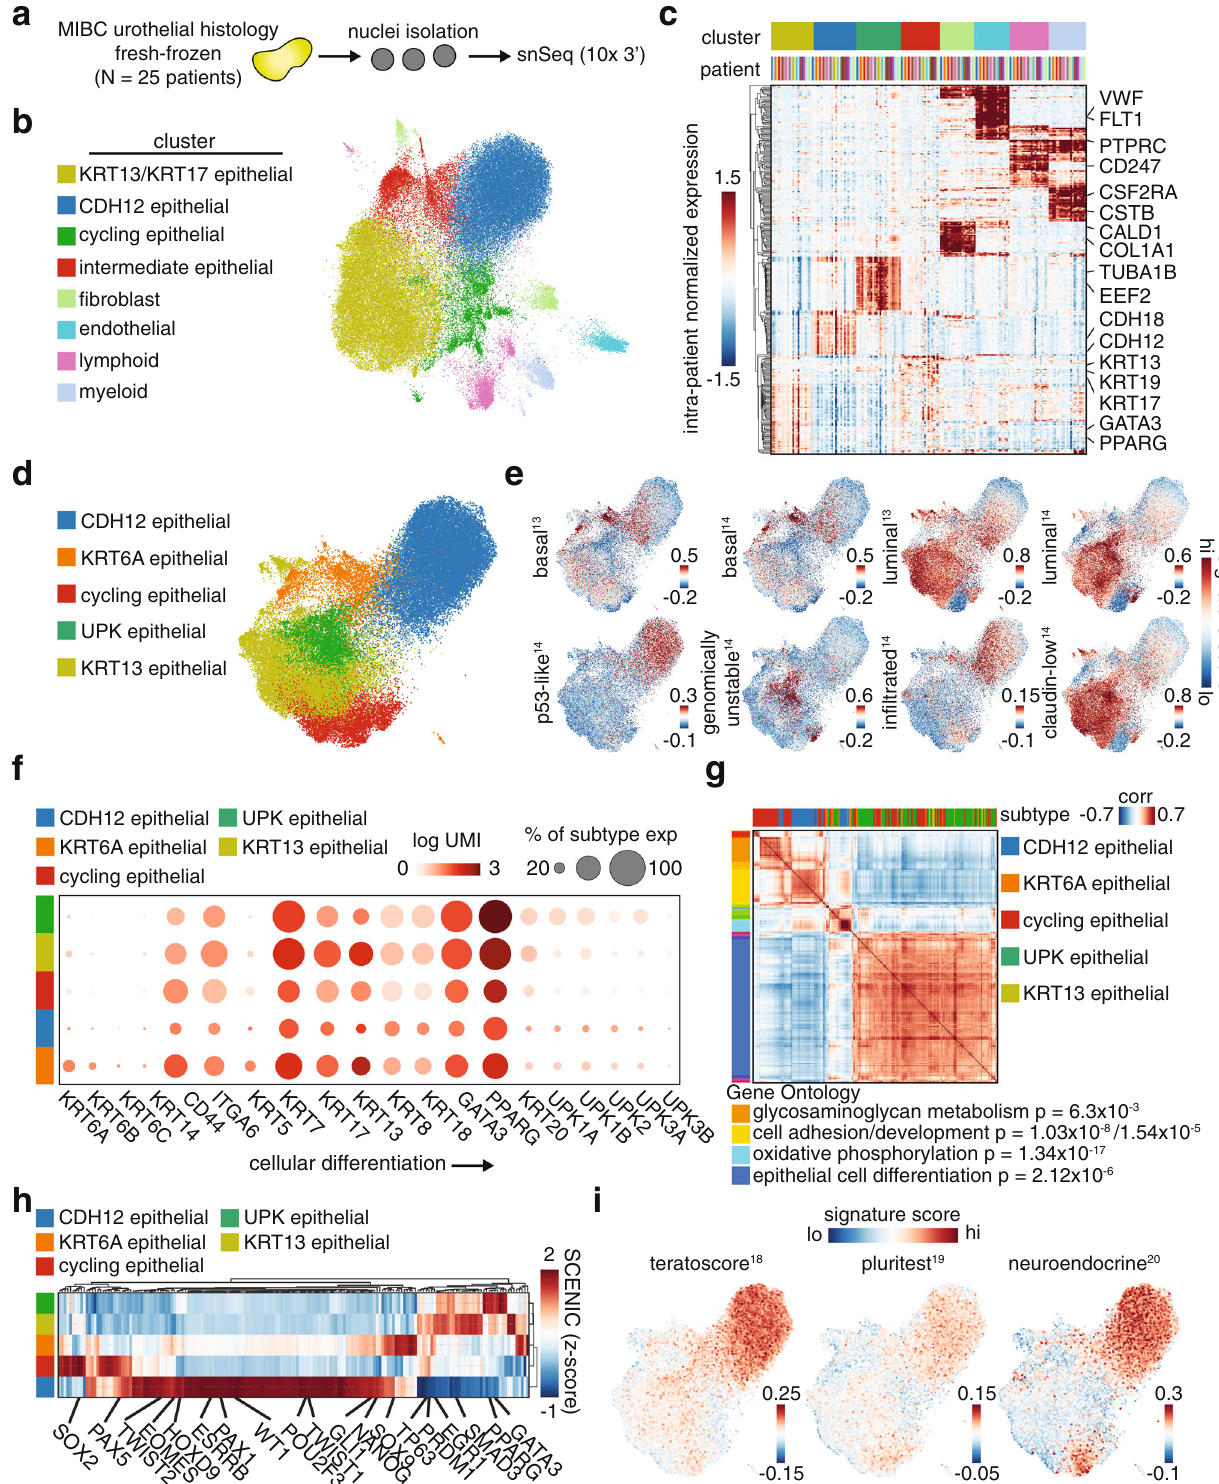
Fig. 1 Discovery of a CDH12 + tumor cell population by single-nucleus sequencing. a Work fl ow for single nucleus sequencing; MIBC — muscle invasive bladder cancer. b UMAP of all nuclei (71,832) in MIBC dataset colored by unsupervised clustering. c Average gene expression per patient of marker genes for each cell type in b . d UMAP of all epithelial nuclei (52,983) in MIBC dataset colored by epithelial population. e Gene signature scores for published MIBC subtype gene sets. f Uroepithelial differentiation-related marker gene expression in each epithelial population, where the dot size indicates the percent of cells within the subtype with non-zero expression of the respective gene. g Gene-gene correlations partitioned into co-expression modules annotated for epithelial population enrichment. Gene ontology (GO) annotations are included with g:SCS multiple testing corrected p-values for hypergeometric testing. h Activity scores for SCENIC transcription factor regulons in each epithelial population. i Gene signature scores for stem-cell and neuroendocrine differentiation gene sets.